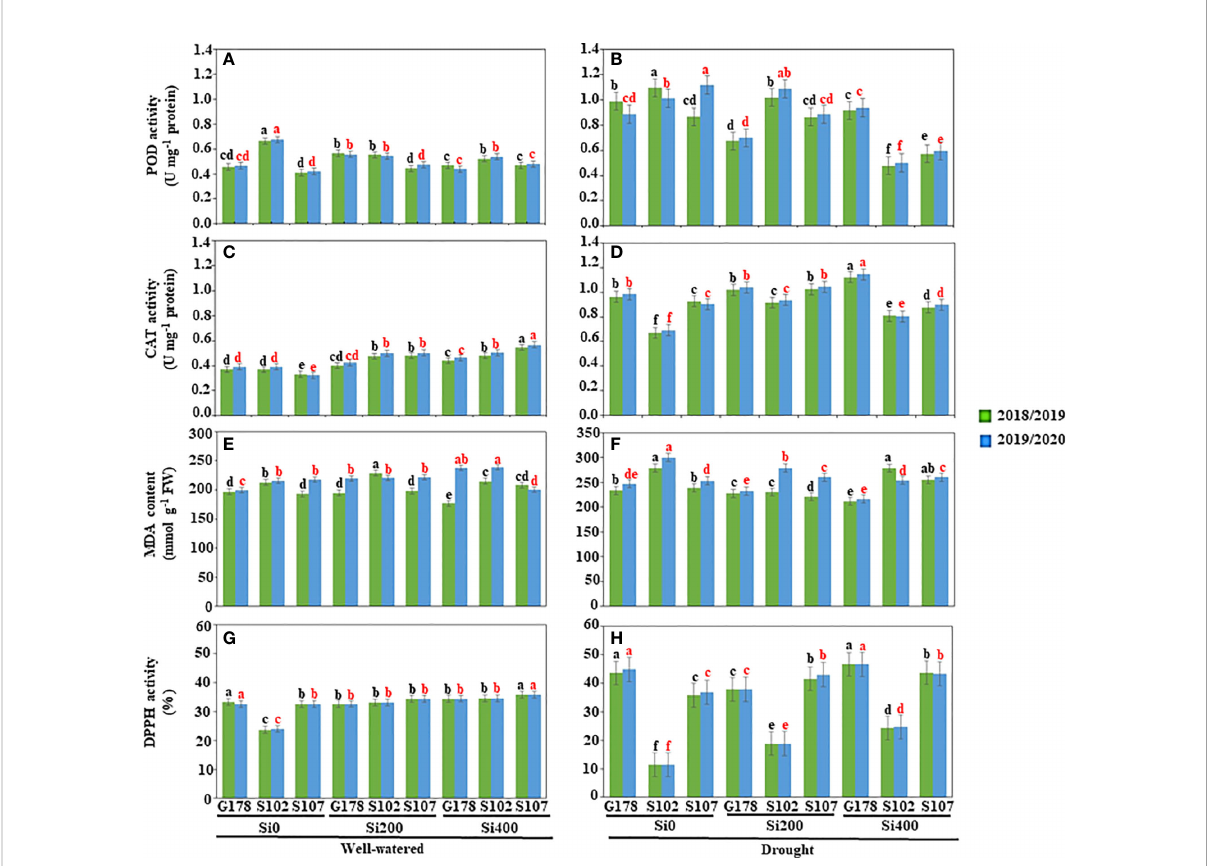
FIGURE 1 Effects of silica (Si) on enzyme activities, lipid peroxidation, and antioxidant potential of rice under drought conditions. Estimation of the antioxidant enzyme activities of (A, B) POD (U mg – 1 protein) and (C, D) CAT (U mg – 1 protein); measurement of (E, F) MDA content (nmol g -1 FW); and (G, H) DPPH radical scavenging activity (%) under well-watered (A, C, E, G) and drought stress (B, D, F, H) conditions. Values are means of six replicates ± standard deviation. Different letters in black and red indicated signi fi cant differences during the 2018/2019 and 2019/2020 seasons, respectively. POD, peroxidase; CAT, catalase; MDA, malondialdehyde; DPPH, and